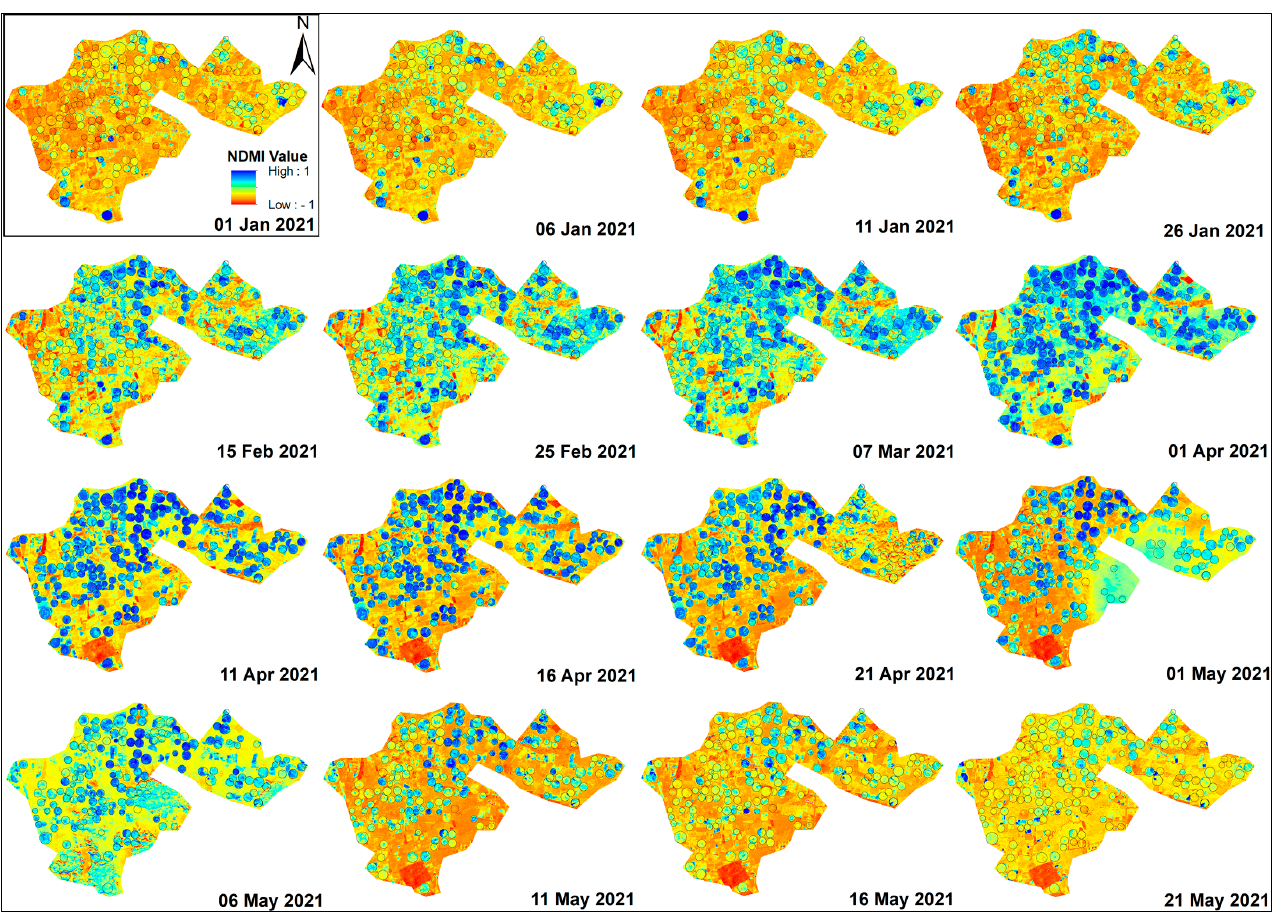
Figure 6. Temporal Variation of the NDMI Value-Based Vegetation Density Classes of Wheat Field in 2021. Table 2. Statistical indices of measured NDMI Value, and area of each Classes.